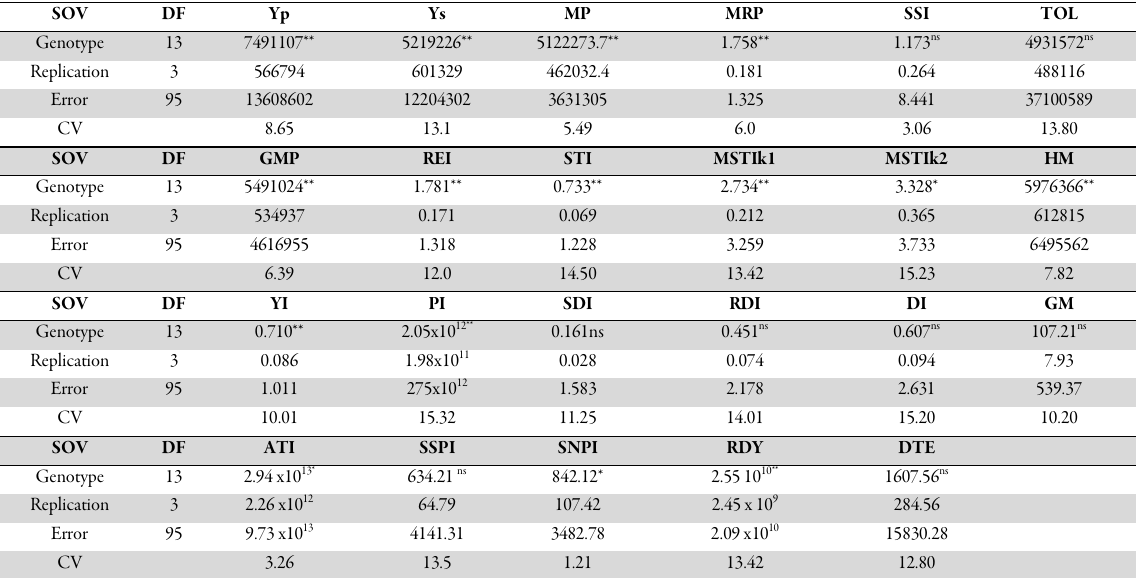
Table 2. Analysis of variance for yield performances of chickpea genotypes in non-stressed and stressed conditions and drought resistance indices